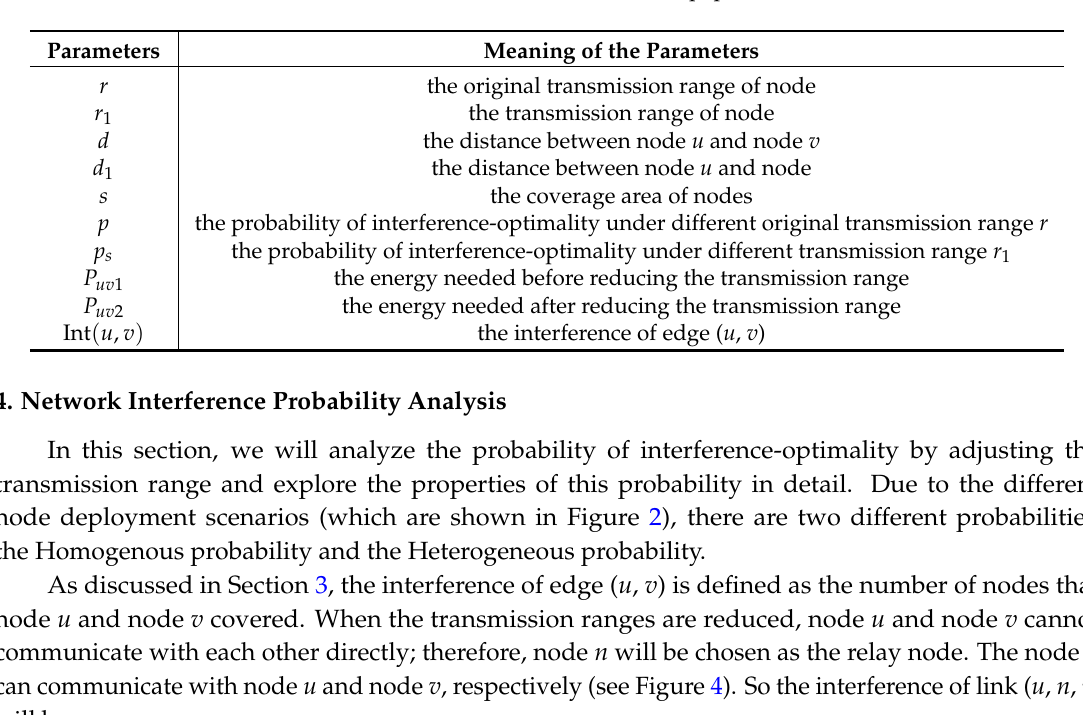
Table 1. The notations used in this